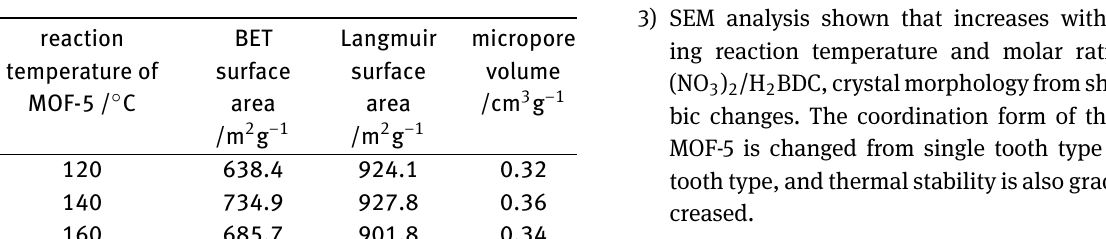
Table 1: Effect of reaction temperature on the textural properties of the crystal MOF-5. reaction temperature of MOF-5 / ∘ C 120